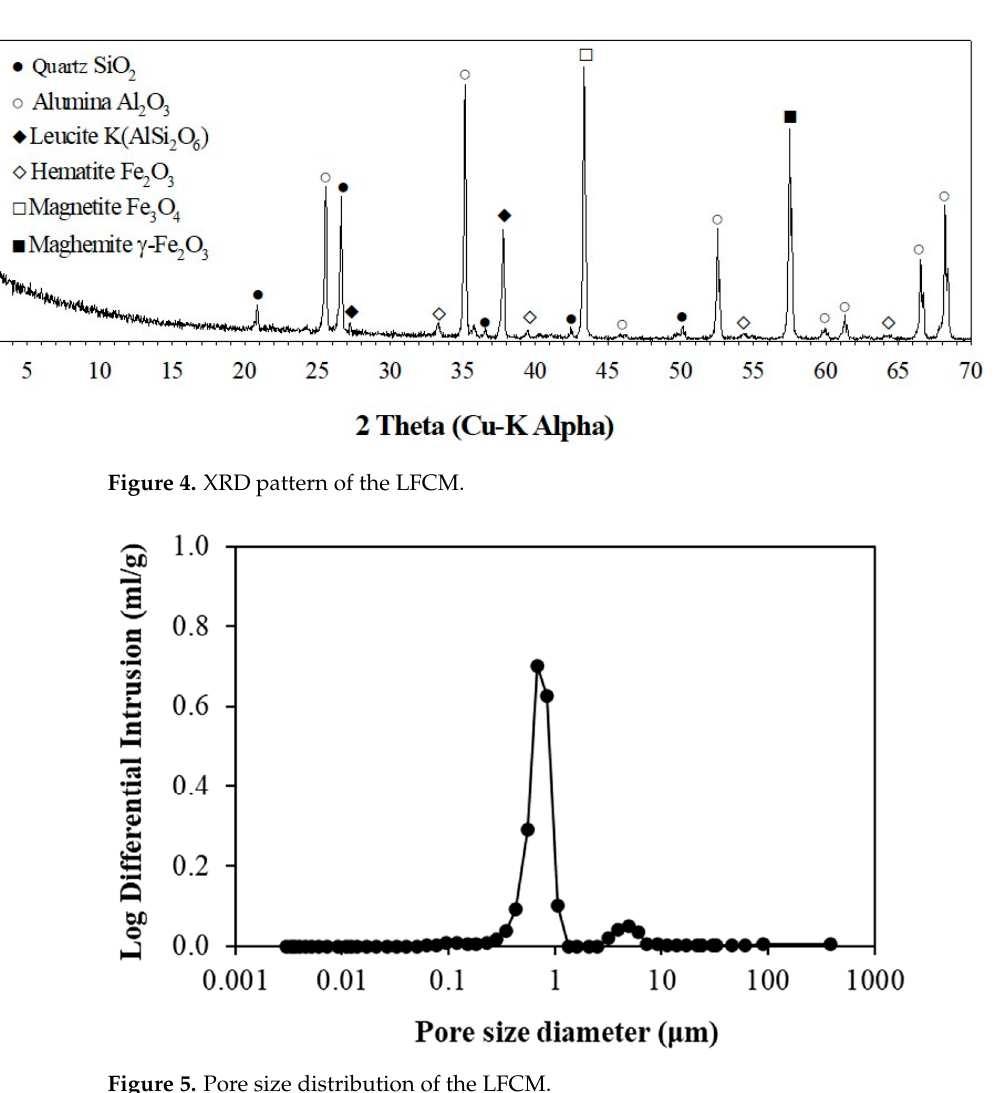
Figure 5. Pore size distribution of the LFCM.